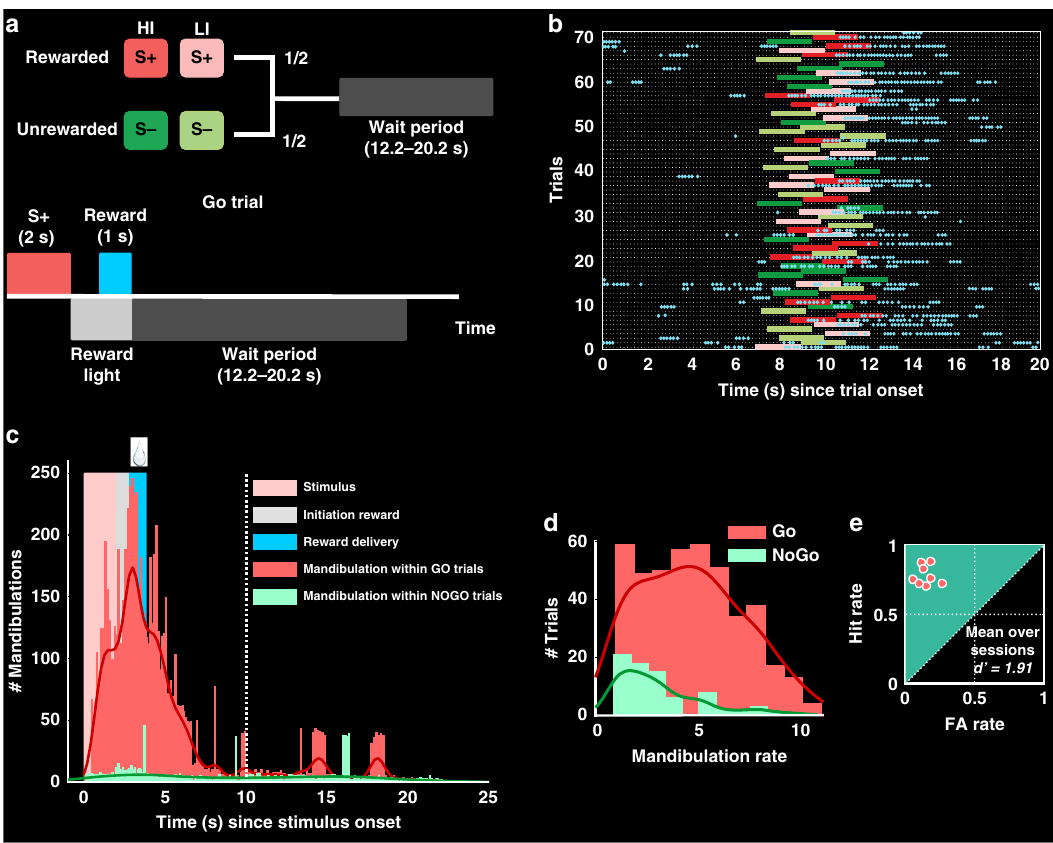
Fig. 2 Behavioral results of the color discrimination task. a Top row shows the experimental design. All events were equiprobable. Bottom row shows the timing of an individual Go (S + ) trial. Animals were rewarded when mandibulating during S + presentations. To avoid stimulus intensity effects during training, two different light intensities (20 and 100% of maximum possible intensity) were used. b Raster plot of a typical session from one pigeon. Time increase from bottom to top for the session and left to right represents the event within single trials (with time-point 0 corresponding to trial onset). During the depicted session, red-light signaled S + and green-light S − trials. Mandibulation was tracked during each single trial. Blue dots represent the animal ’ s mandibulations, which happened mostly during S + presentations and reward periods. c Histogram showing an overlay of mandibulations both during Go and NoGo trials in a group analysis of eight pigeons (with time-point 0 corresponding to stimulus onset). Dotted line shows the end of the post-reward period. d Mandibulation rate histogram. Group analysis showed that mandibulation rate over all S + trials was signi fi cantly higher than over all S − trials (two-tailed t test, t (654) = 9.66, p = 9.99e − 21). e Behavioral results of all pigeons over all test sessions. Each data point represents the projected Hit/FA pairs to the ROC space. Source data are provided as a Source Data fi and NoGo periods (Fig. 2c, d) as an estimate of discrimination performance. High hit and low false-alarm (FA) rates across animals represented an optimal trajectory on a receiver operant characteristic (ROC) chart (Fig. 2e). The mean reaction time ( fi rst mandibulation after stimulus onset) during S + and S − trials was 0.9 ± 0.4 s (mean ± SD, hits) and 0.7 ± 0.5 s (mean ± SD, FAs), respectively.